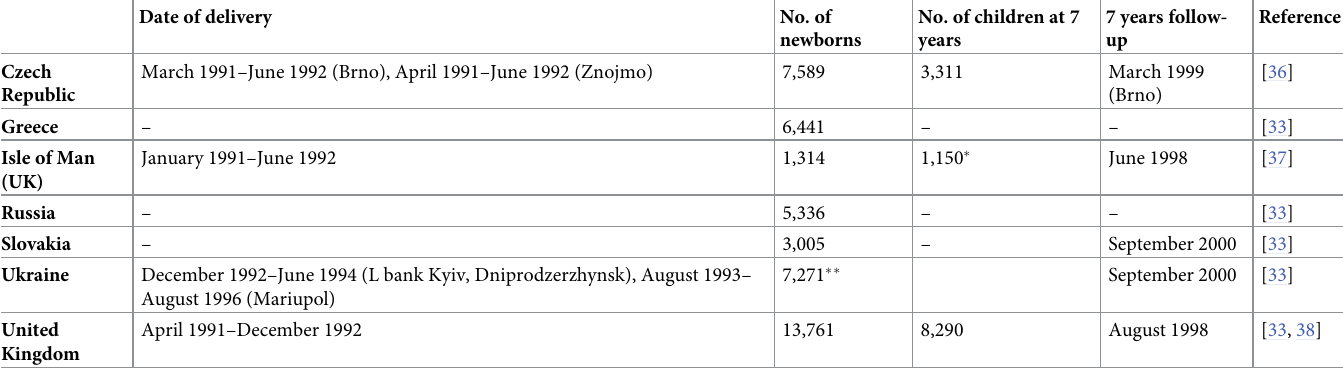
Table 1. Basic information on countries participating in